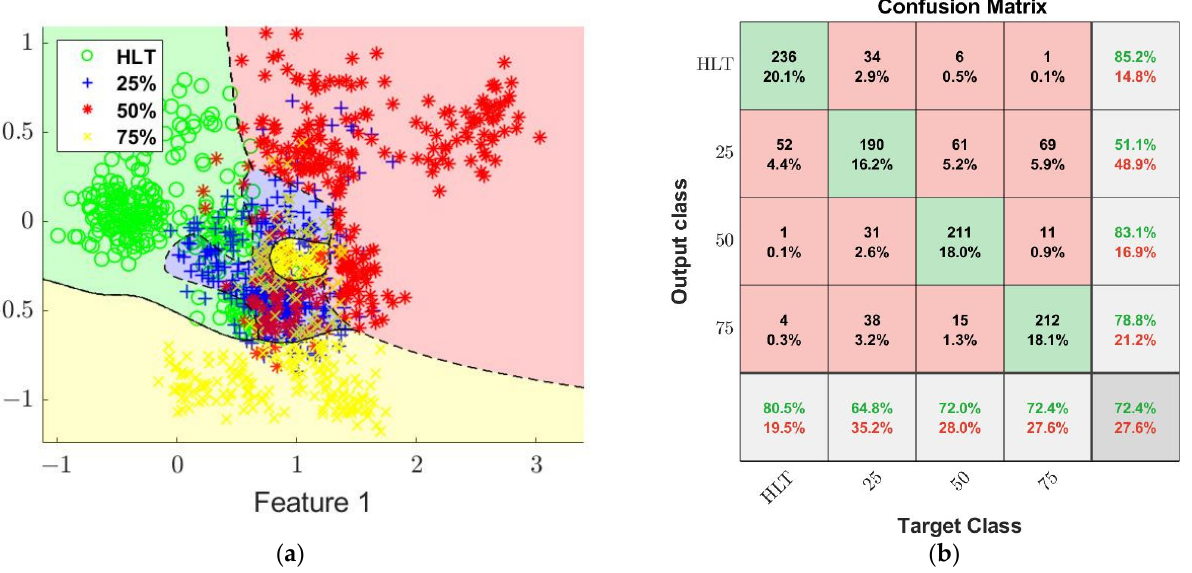
( b ) Figure 9. Features optimization through GA for Ay and Az vibration signals (not data fusion is con- sidered), in ( a ) Two-dimensional projection of clusters (fault conditions) through LDA with limit bounds, and ( b ) Confusion matrix that validates the ANN classification of faults. Regarding the observed results from the figure, the following can be discussed. The LDA projection in 2D of the optimized features from vibration signals in Figure 9a shows a clear separation of the regions that delimit the four conditions analyzed and, likewise,